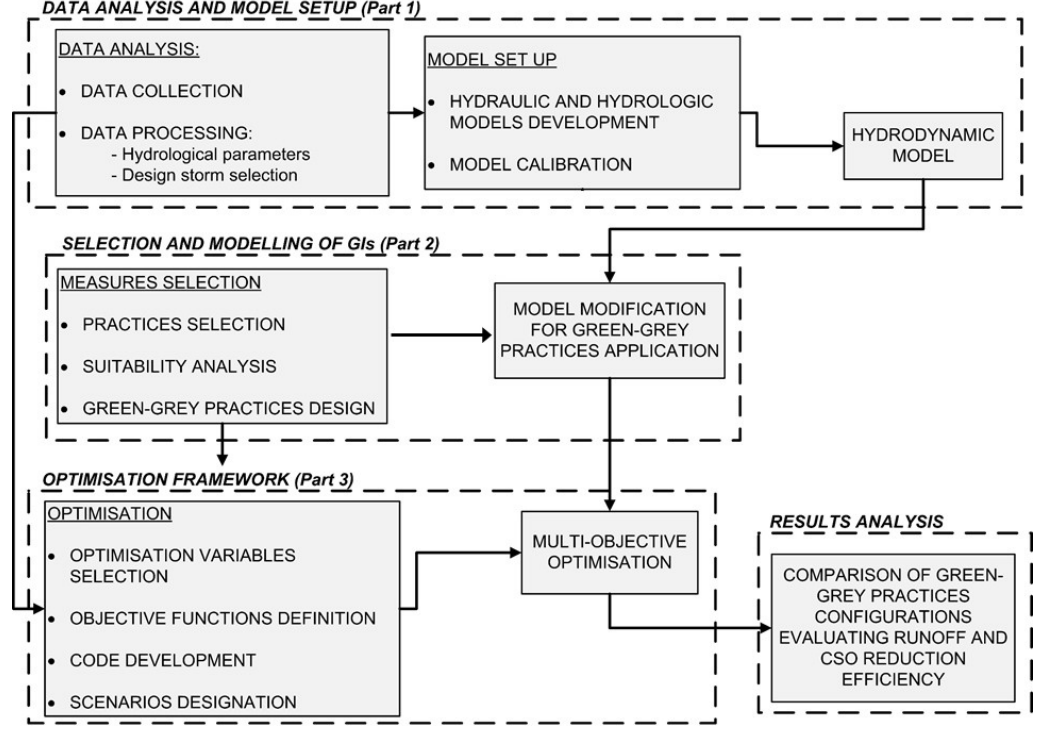
Figure 1. Different parts included in the proposed methodology.